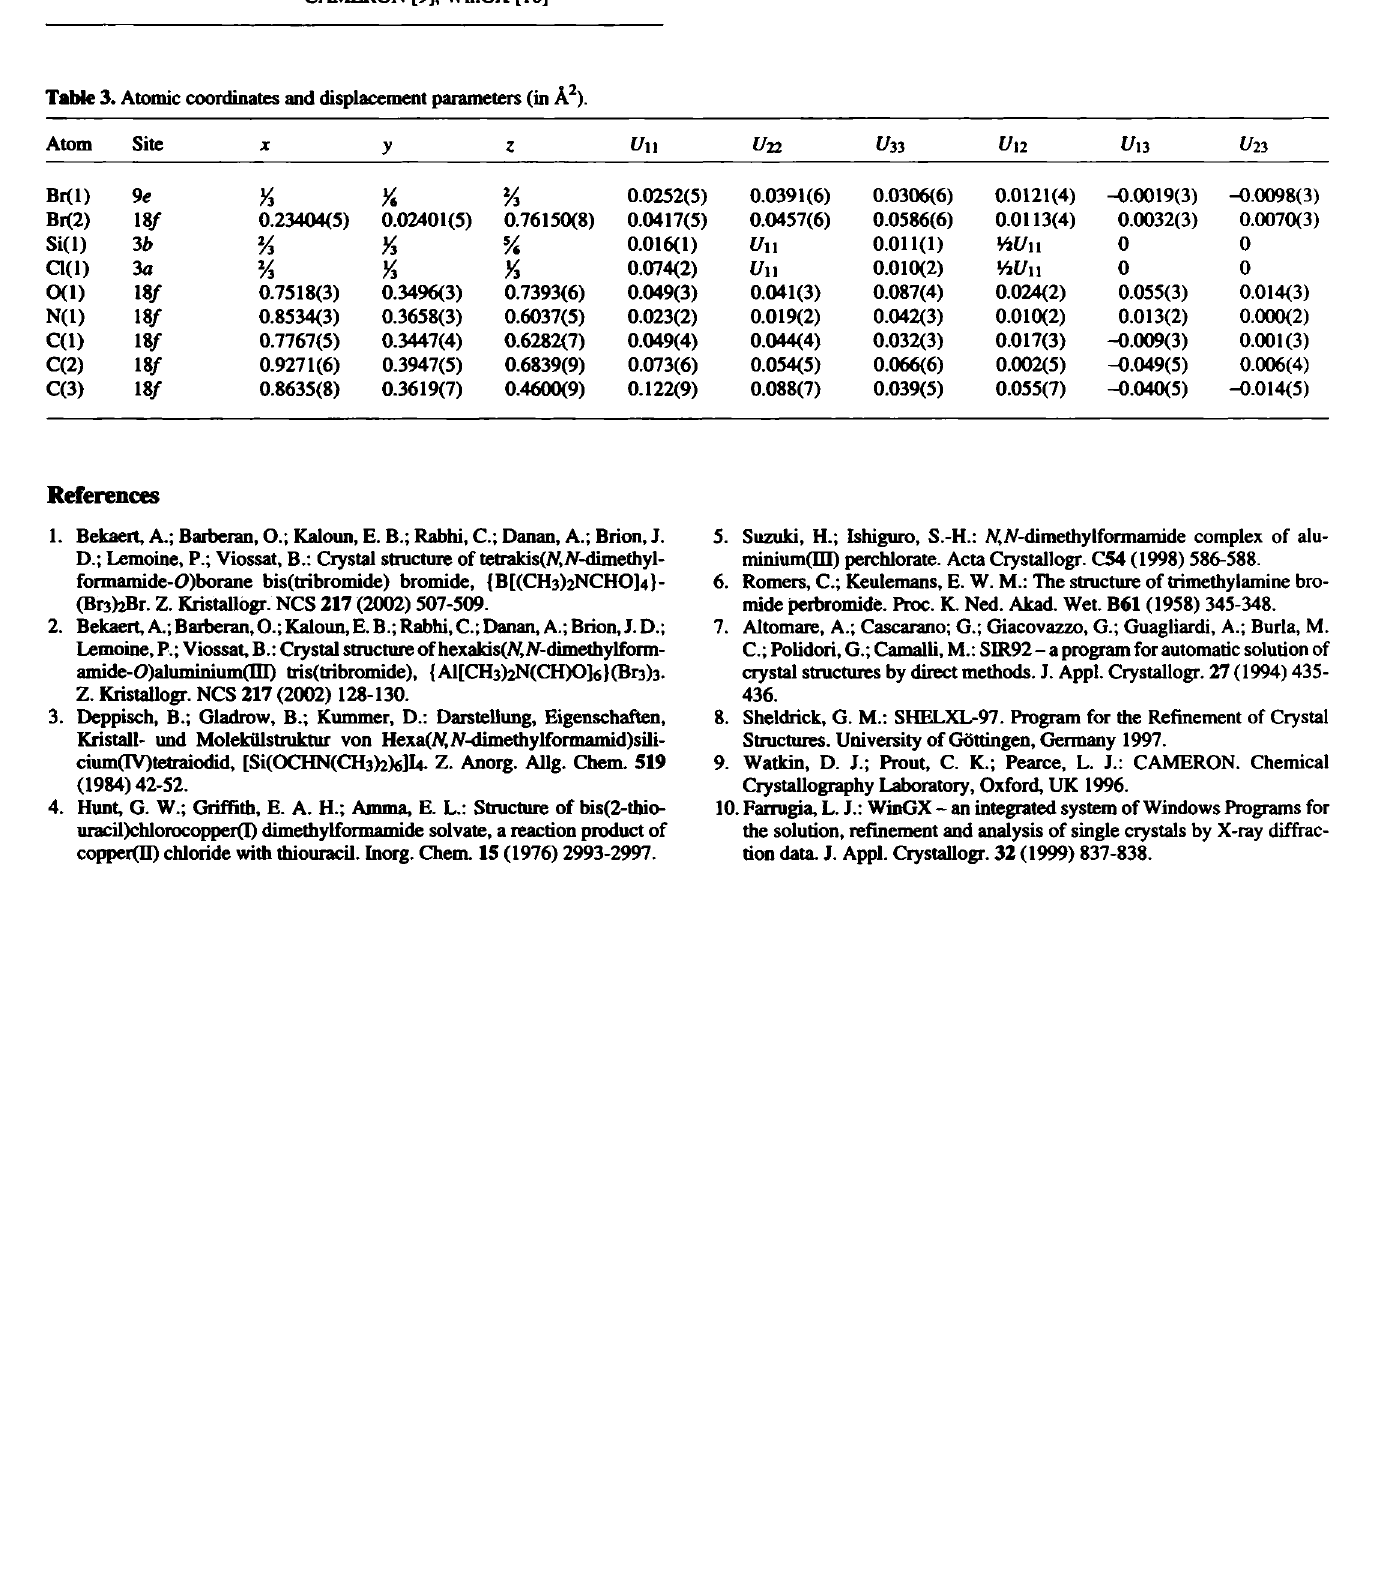
Table 3. Atomic coordinates and displacement parameters (in A 2